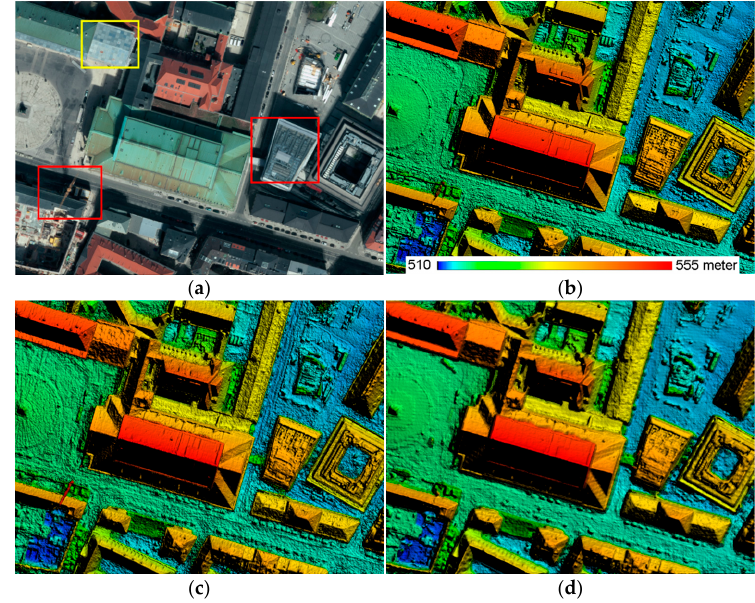
Figure 16. Results on München subset: ( a ) true orthophoto; ( b ) ground truth; and ( c , d ) DSMs generated by SURE and SGVLL, respectively.